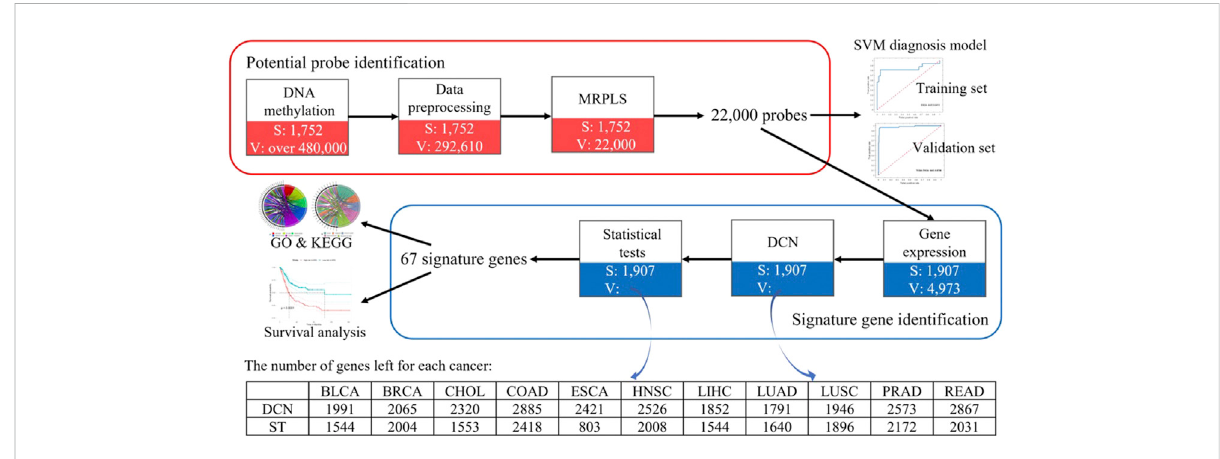
TABLE 1 Details of the training and independent test sets.